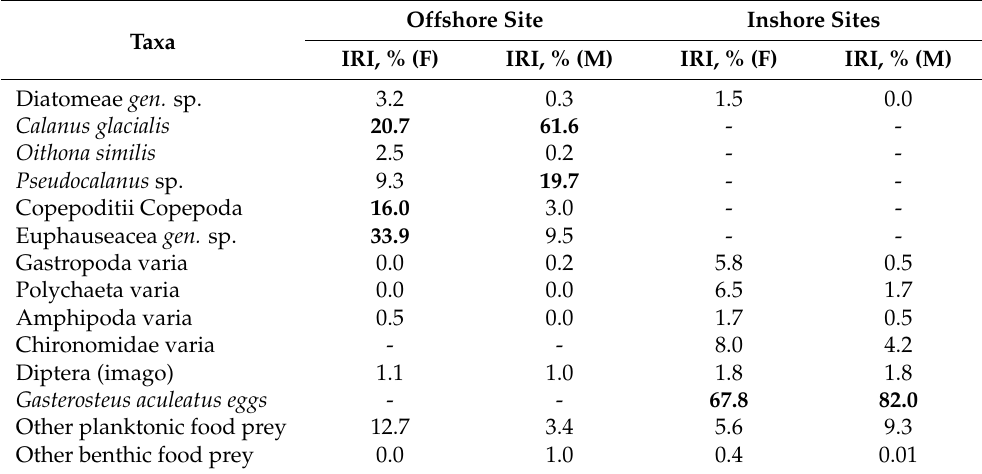
Table 2. Stomach contents (IRI, %) of females (F) and males (M) at the offshore and inshore sites. Offshore Site Inshore Sites Taxa